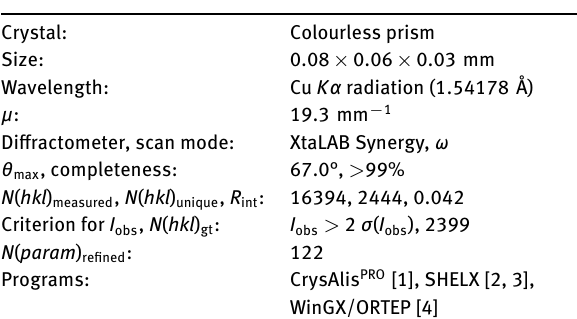
Table 1: Data collection and